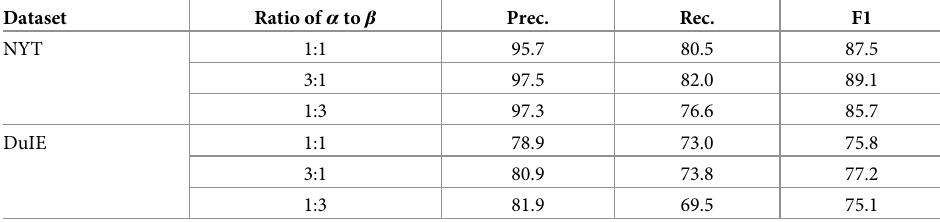
Table 6. Comparison experiment results of mapping strategy.